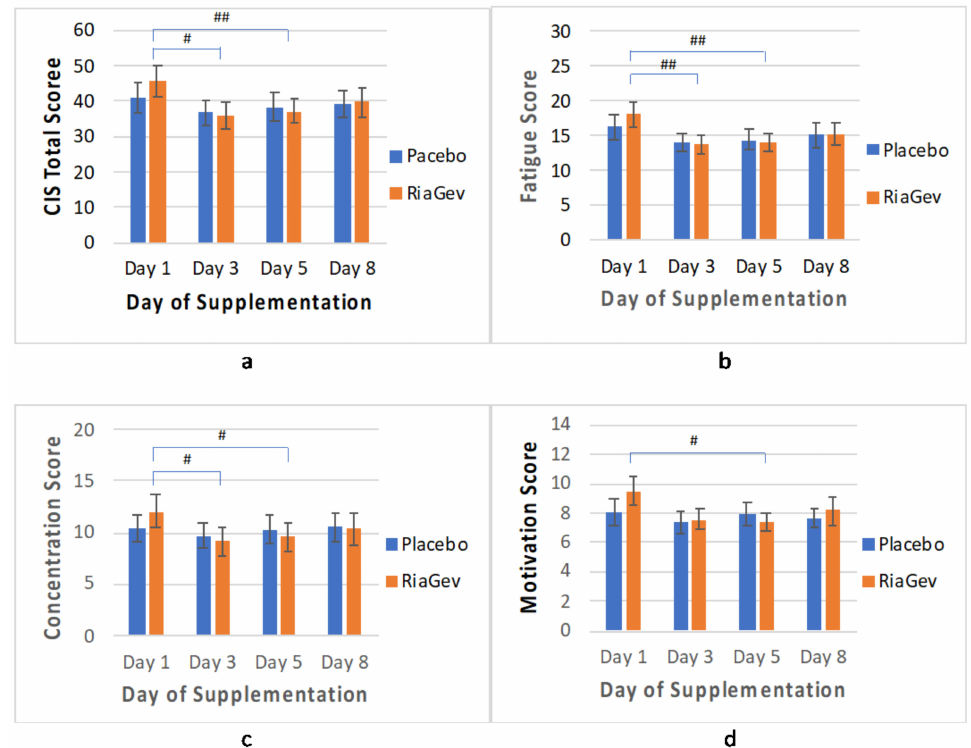
Figure 7. Checklist Individual Strength (CIS) Questionnaire Test for Physical and Mental Fatigue. The CIS total score ( a ) indicates physical and mental tiredness, with four subscales reflecting physical fatigue ( b ), concentration ( c ), motivation ( d ), and physical activity (not shown). Both RiaGev and placebo improved physical and mental fatigue scores during the study. However, the RiaGev group had consistently greater improvements than the Placebo. Additionally, the RiaGev group improvements reached statistically significant levels. Significant changes are marked by # ( p < 0.05) and ## ( p <